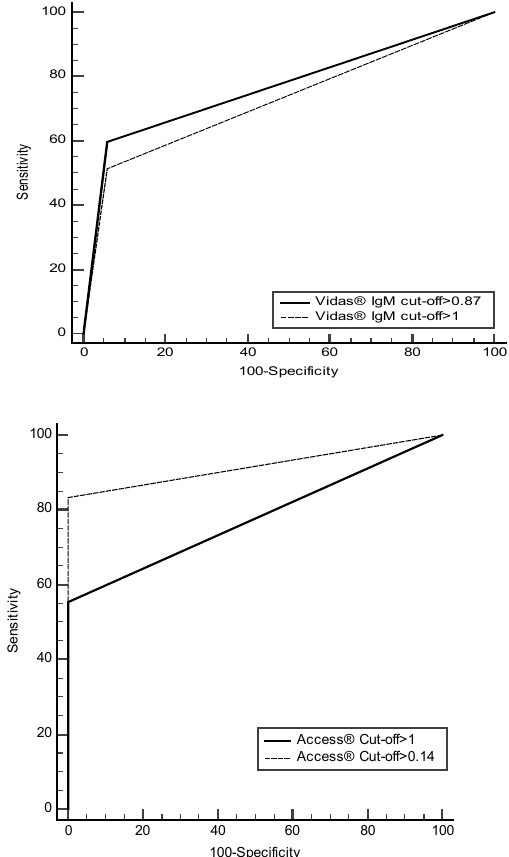
Figure 1. ROC curves of Vidas ® IgM test (at the top) and Access ® test (at the bottom) using the original cut-offs (continuous line) and the proposed cut-offs (discontinuous line), p < 0.05, diagonal line shows equality.